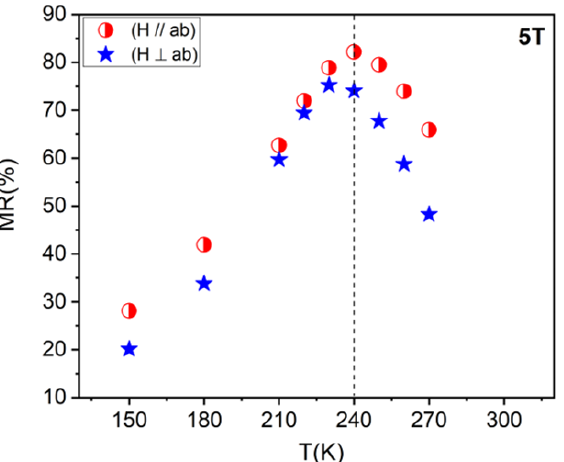
Figure 7. Temperature dependence of magnetoresistance MR of the LBMTO-5 thin film, measured under a magnetic field of 5 T along in-plane and out-of-plane geometry.